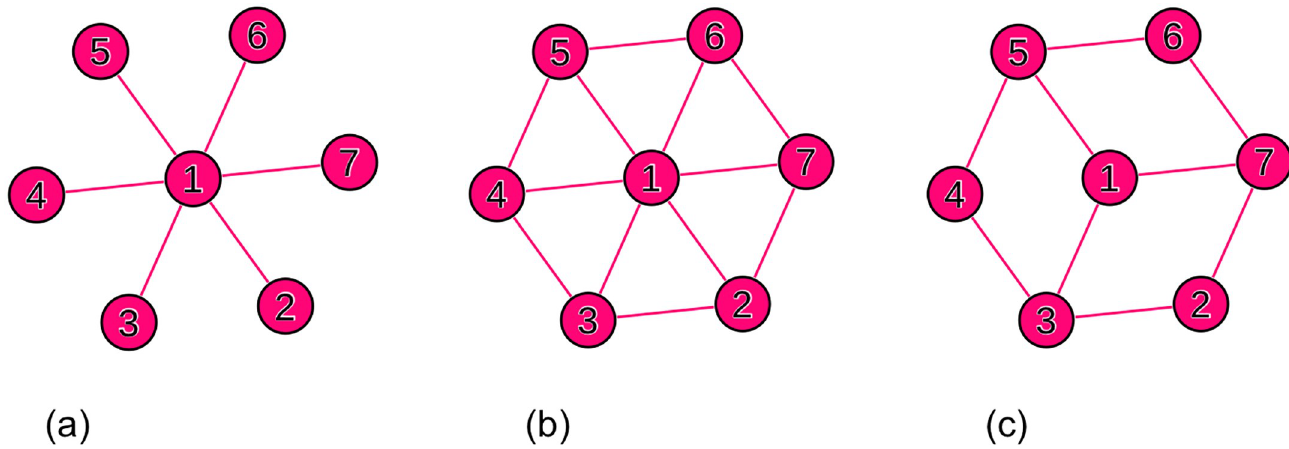
Fig 6. An illustration model to show different connection patterns in settlement network and relative changes in Global Reaching Centrality (GRC): (a) GRC = 0.42, (b) GRC = 0.25, (c) GRC = 0.07.